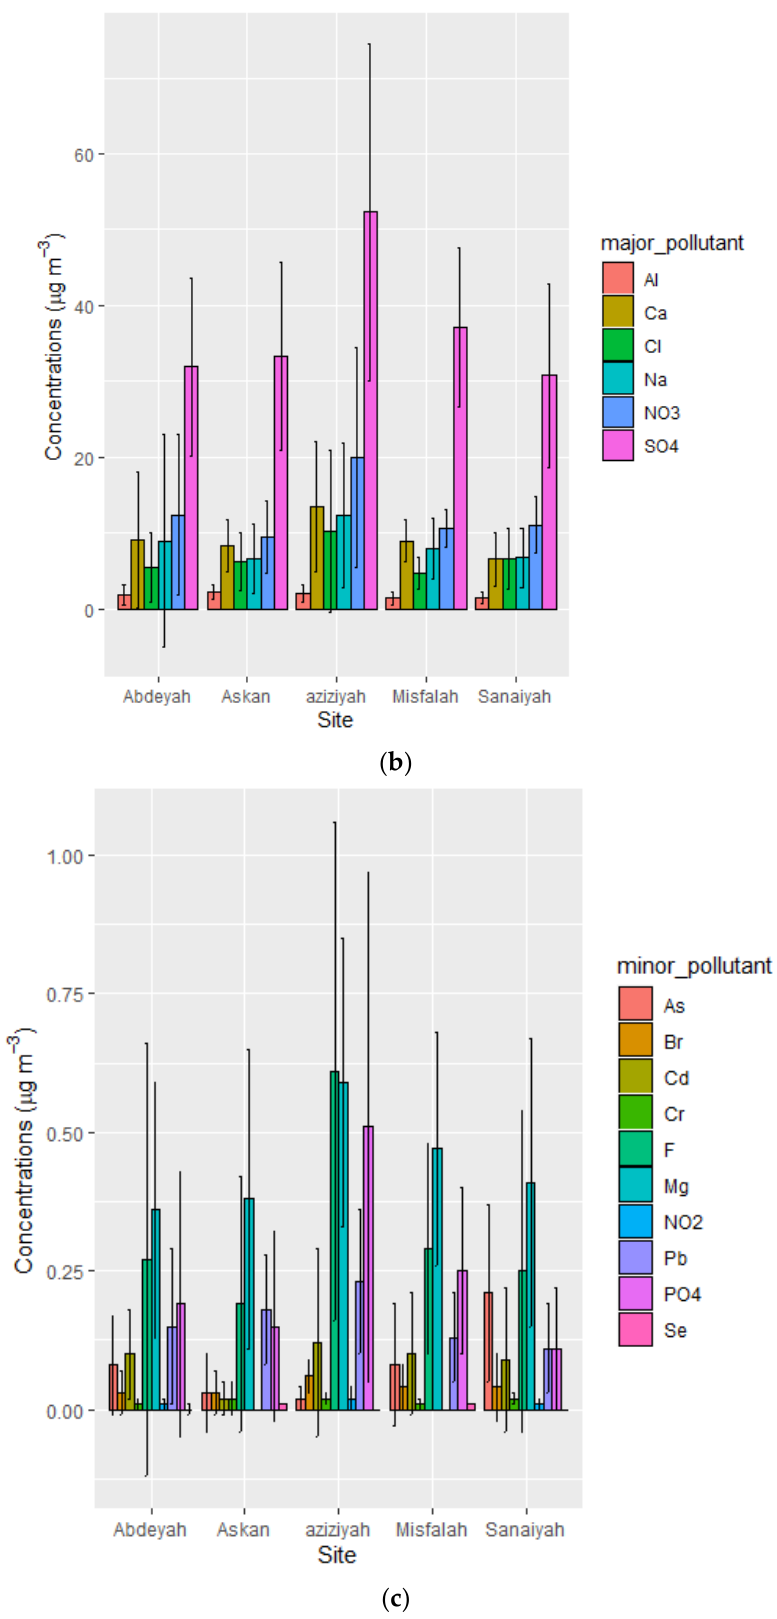
Figure 2. The concentrations of PM 10 ( a ), major constituents ( b ), and minor constituents ( c ) at different monitoring sites in Makkah.